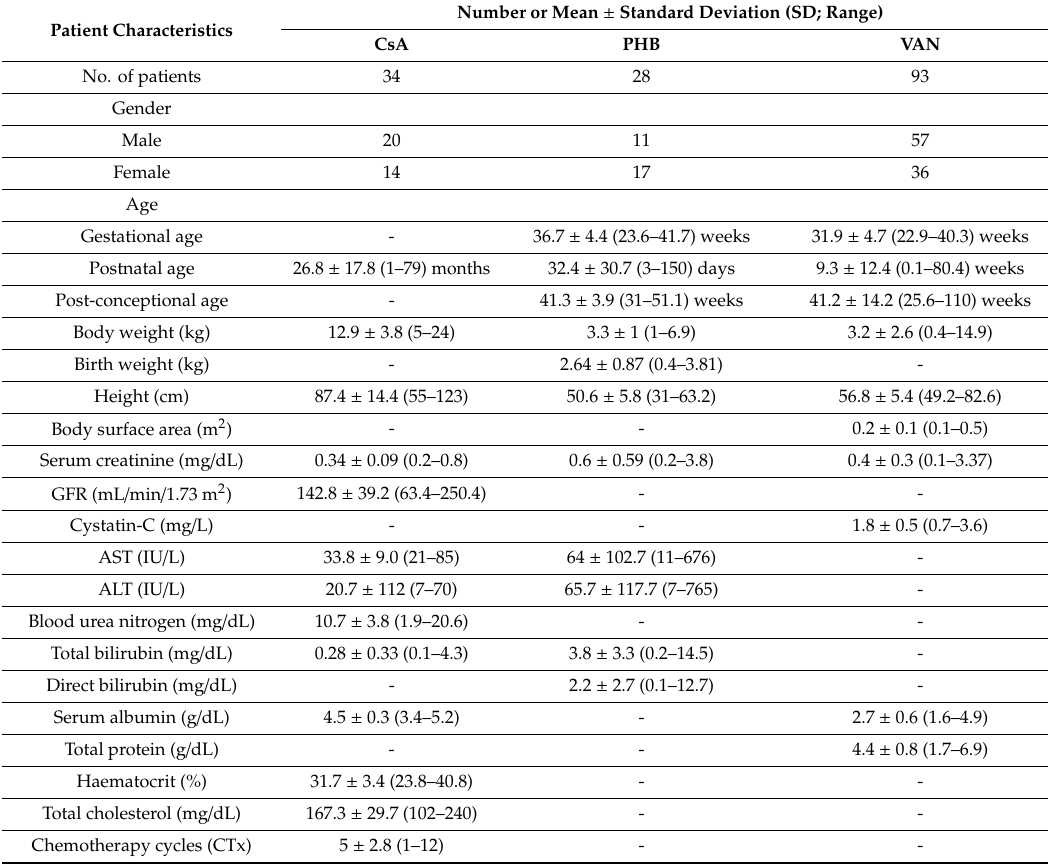
Table 1. Demographic information for cyclosporine A (CsA), phenobarbital (PHB) and vancomycin